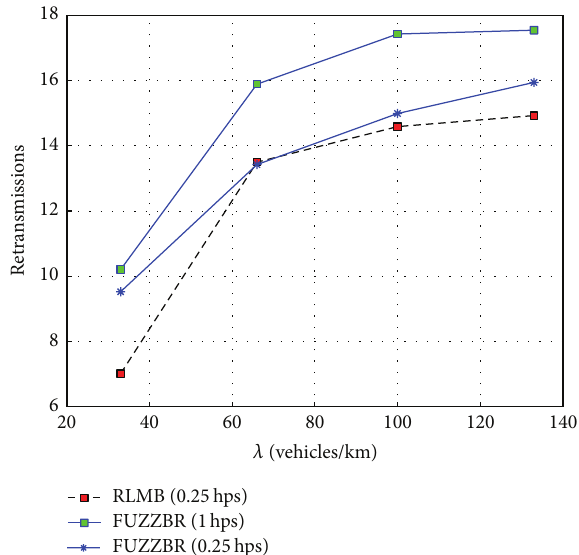
Figure 12: EED obtained with RLMB (0.25 hps) and FUZZBR (0.25 hps) when increasing the transmitter-receiver distance for different vehicles densities, 𝜆